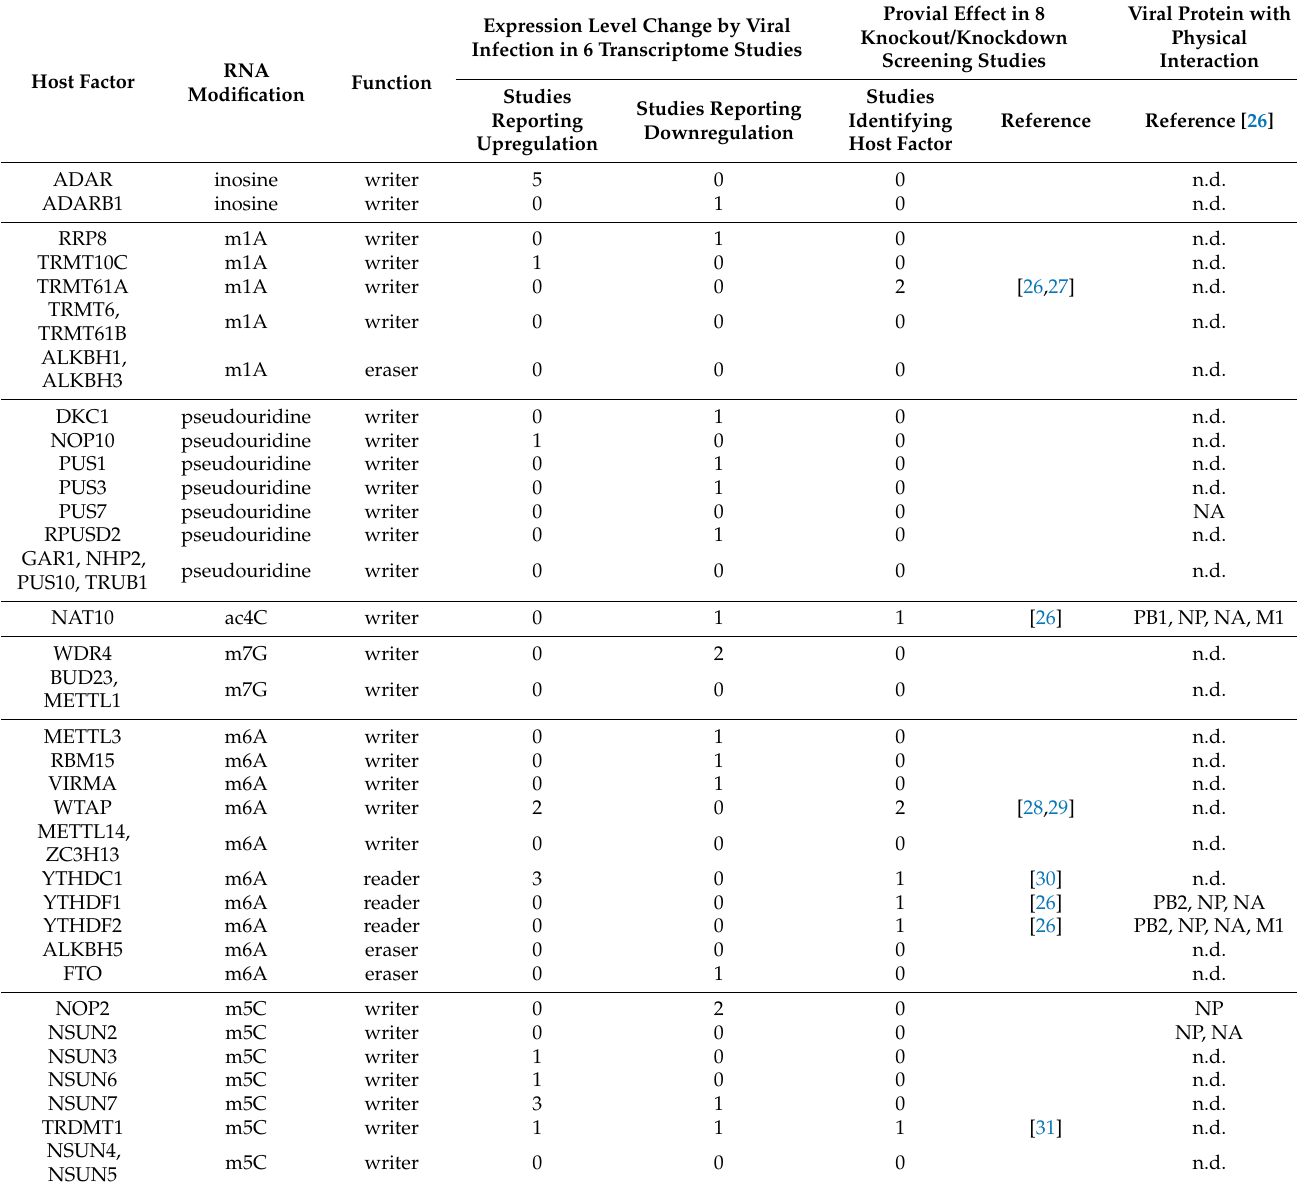
Table 1. Relationship between viral infection and host factors for RNA